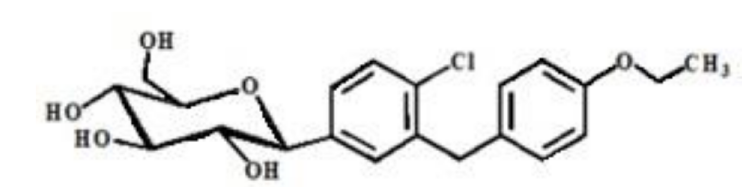
Figure 1. Chemical structure of Dapagliflozin